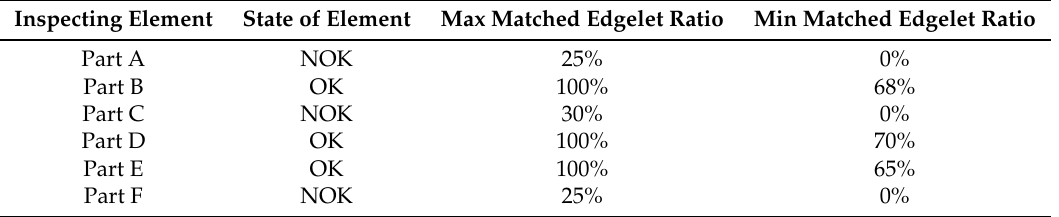
Table 3. Determination of optimal parameter for making decision on state of element.